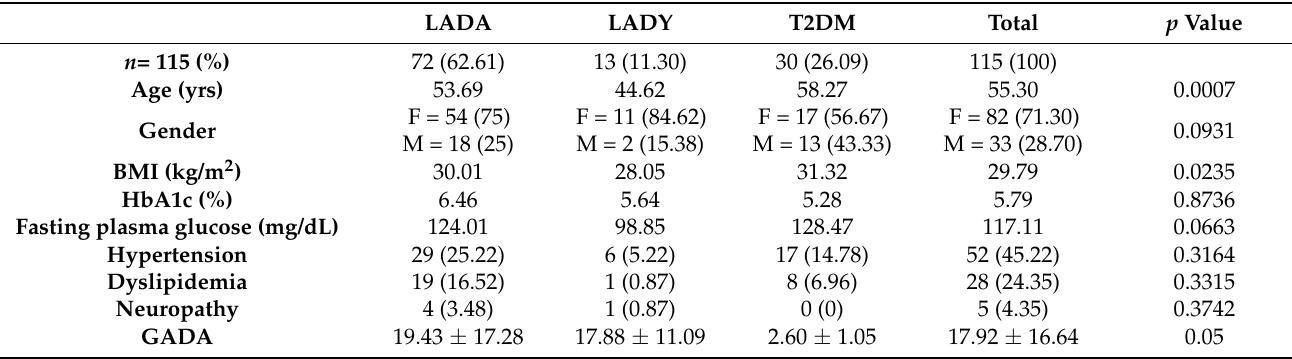
Table 1. Clinical and metabolic variables.